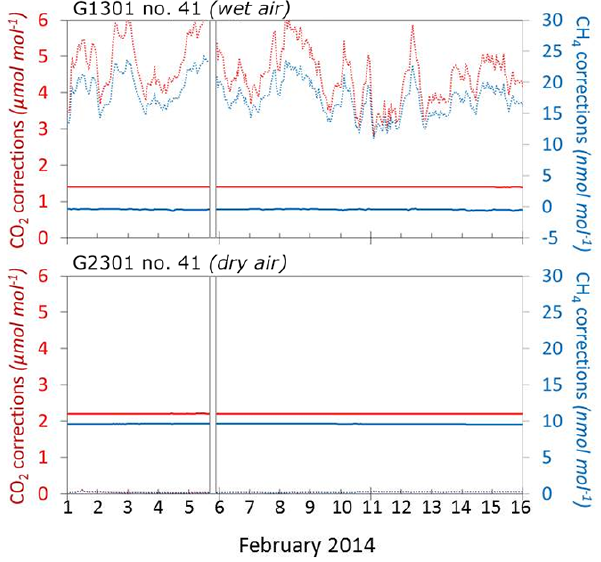
Figure 6. Water vapor corrections (dashed lines) and WMO calibra- tion corrections (thick lines) applied to CO 2 (red) and CH 4 (blue) mole fractions for two CRDS analyzers used at Mace Head station (above: no. 41 measuring wet air; below: no. 54 measuring dry